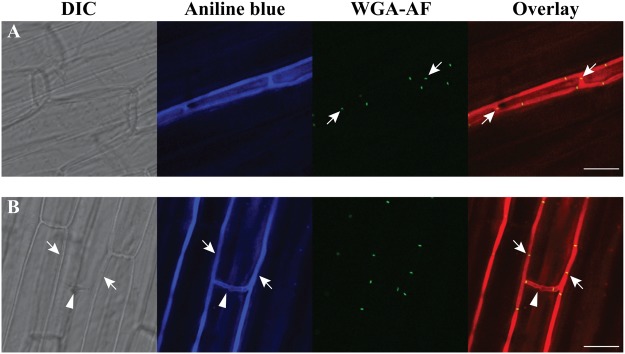
Vegetative hyphal fusion of E. festucae Fl1 in the tall fescue leaf sheath.Confocal micrographs of DIC optics, aniline blue staining showing fungal hyphae, Alexa Fluor 488-conjugated wheat germ agglutinin (WGA-AF) showing septa, and overlaid images with aniline blue staining pseudocolored in red. (A) Arrows point septa in two short hyphae connecting two hyphae extending in parallel. (B) Two hyphae (arrows) connected by a short hypha (arrowhead) which presumably underwent vegetative hyphal fusion. Locations of all three hyphae correspond to outlines of plant cells (compare DIC and aniline blue images). Bars represent 20 μm.